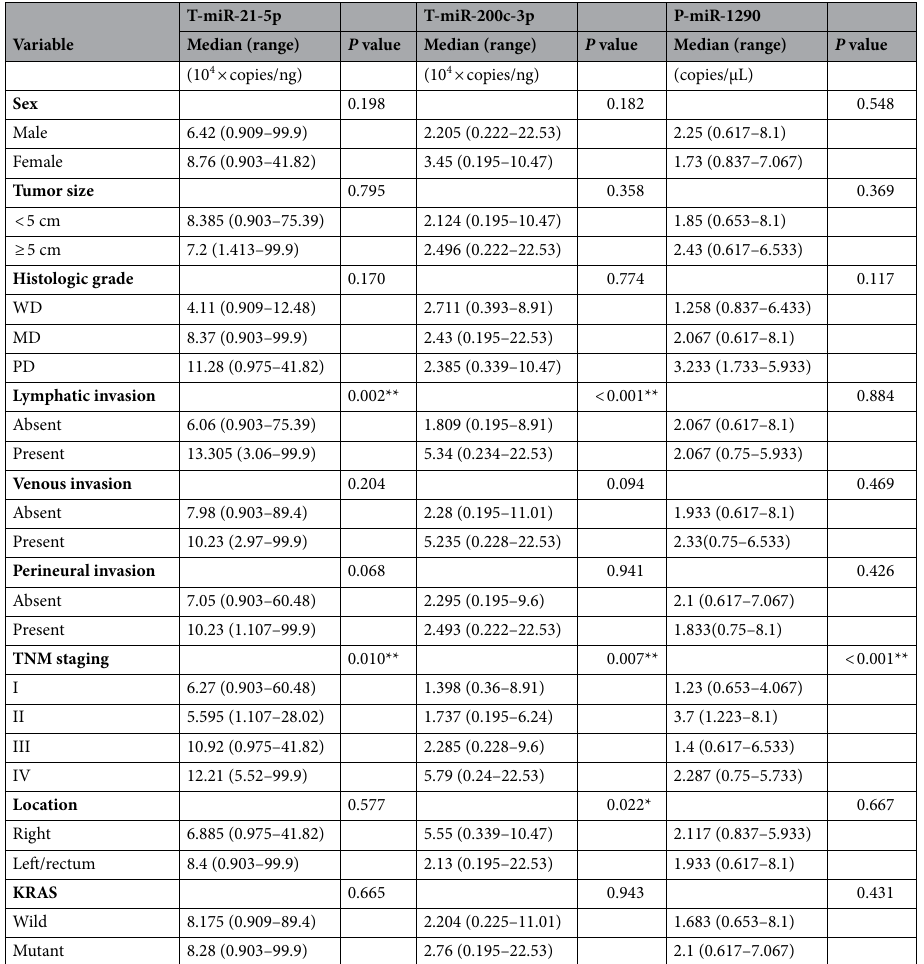
Table 3. Relationship between the concentration of tissue microRNA-21-5p, 200c-3p, and plasma microRNA-1290 and clinicopathologic features. Data are presented as Median (range). * P -value < 0.05, ** P -value < 0.01. T-, tissue; P - plasma. SD standard deviation, WD well differentiated, MD moderately differentiated, PD poorly